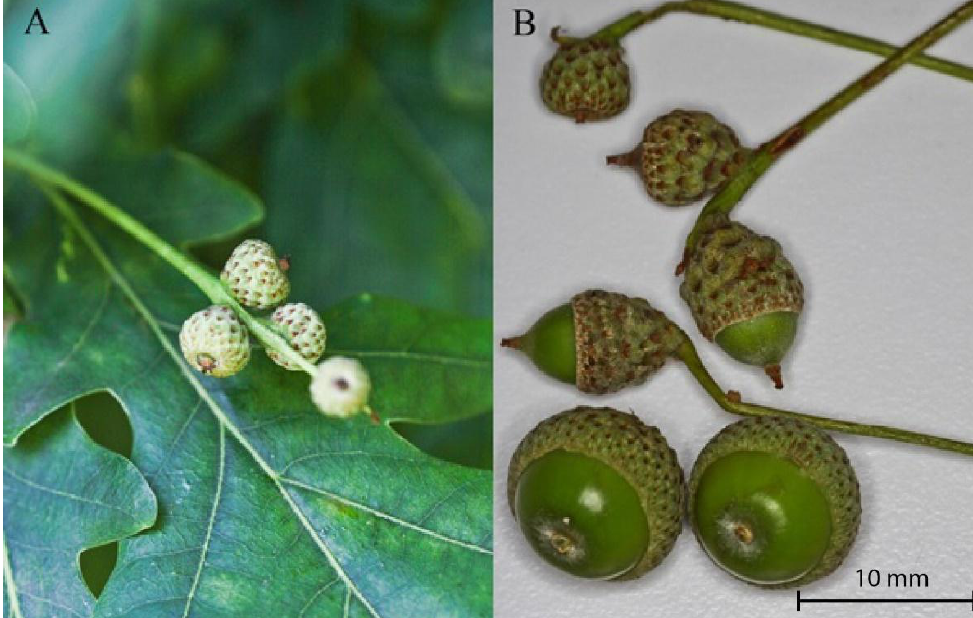
Figure 4. Acorns in the early stage of growth: ( A ) fruits in June are usually very small—taken on 16 June 2014, ( B ) acorns during growth vary in size and shape between trees—photo taken on 8 July 2014.